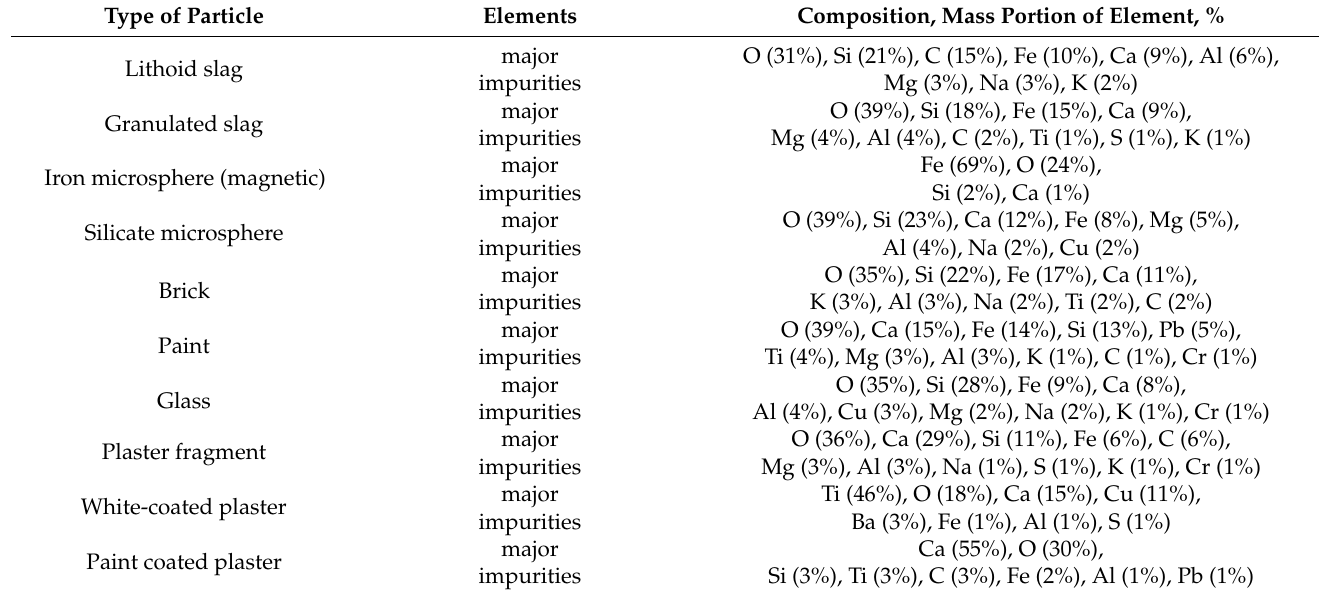
Table 5. The chemical composition of the surfaces of various types of particles without inclusions according to scanning electron microscopy (SEM) analysis.